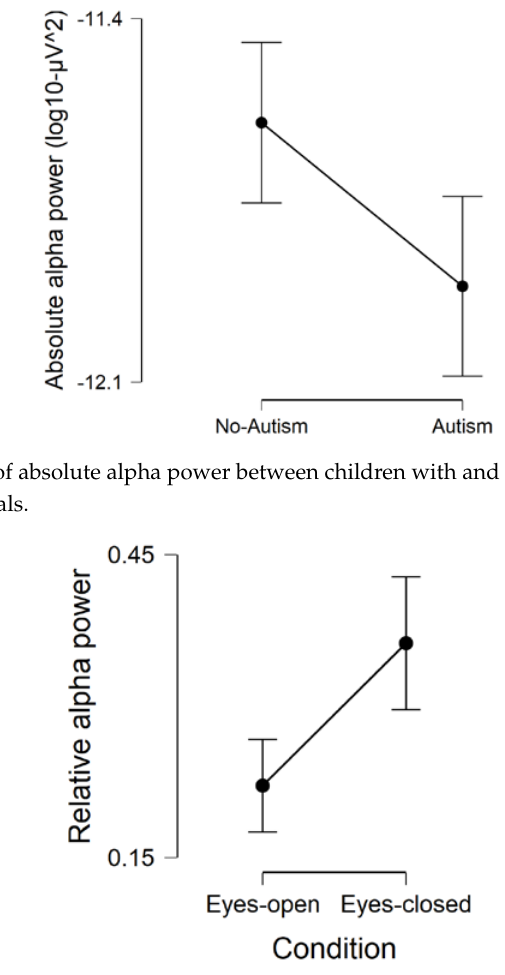
Figure 3. Comparison of relative alpha power during eyes-open and eyes-closed resting-state conditions. Error bars are 95% credible intervals.